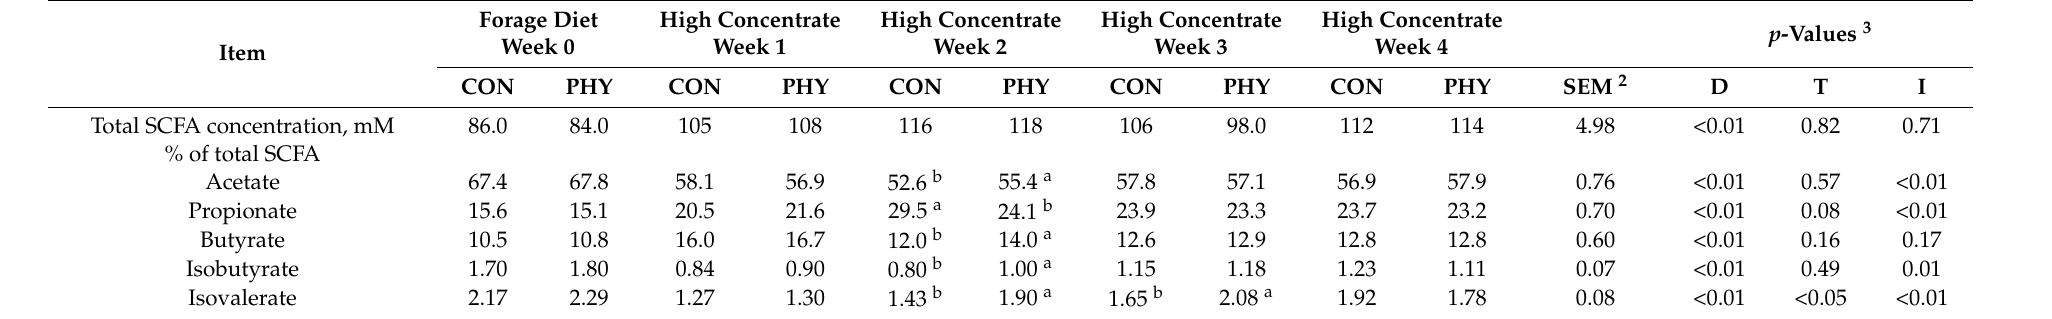
Table 3. Effect of supplementation with a phytogenic feed additive based on L-menthol, thymol, eugenol, mint oil ( Mentha arvensis ) and cloves powder ( Syzygium aromaticum ) on ruminal short chain fatty acid profile, ammonia and lactate in cows consuming a forage diet or a high concentrate diet 1